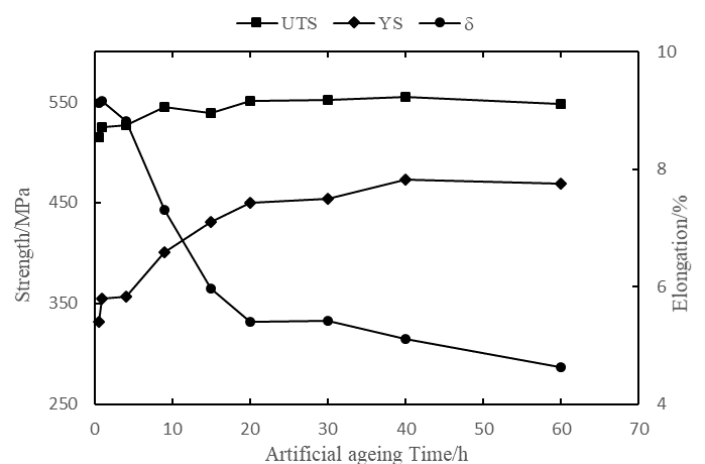
Figure 4. Variations of ultimate tensile strength (UTS, left y -axis) in engineering stress, yield strength (YS, left y -axis) in engineering stress and elongation ( δ , right y -axis) of SiCp–AA2009 composites aged at 170 ◦ C with different time under CHT